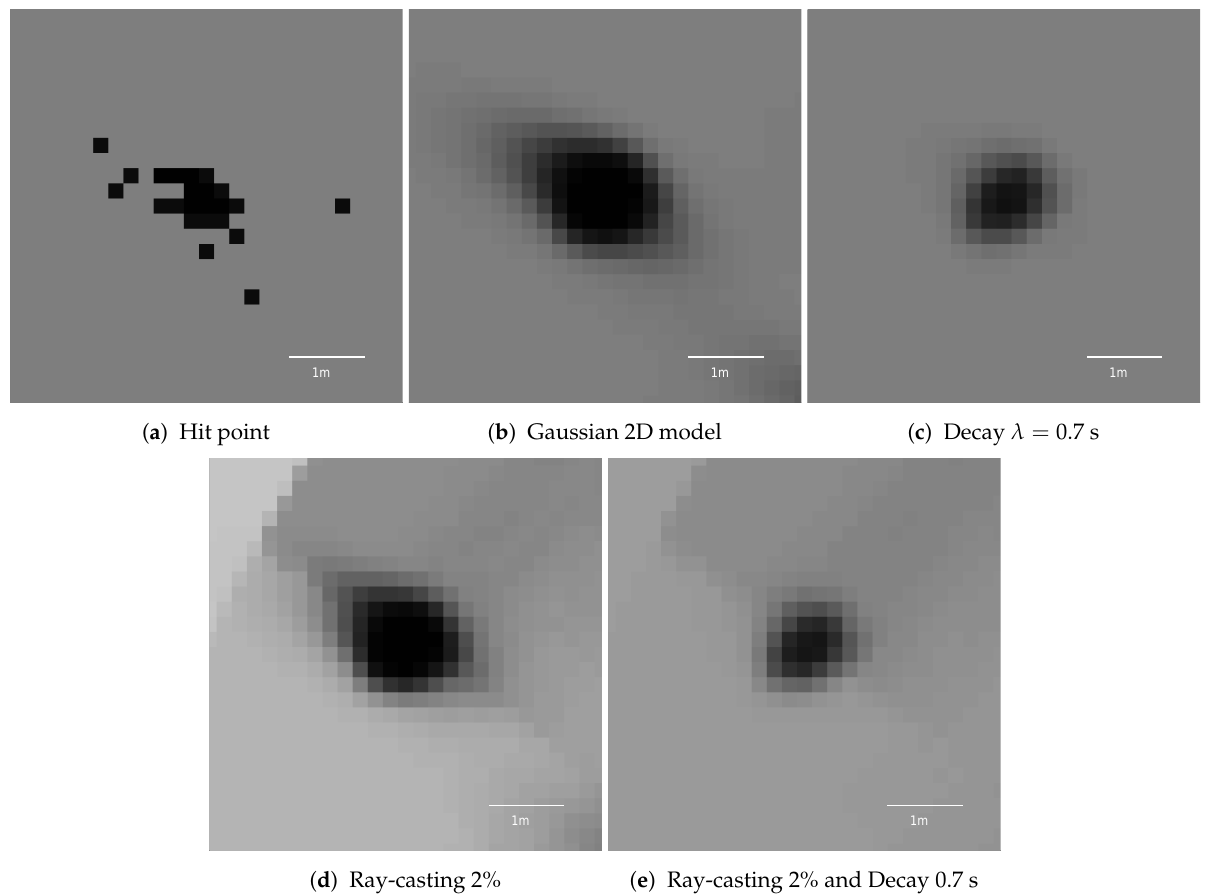
Figure 19. Occupancy grid representation of the pole in the experimental data. The presented snapshots are raw grid data without